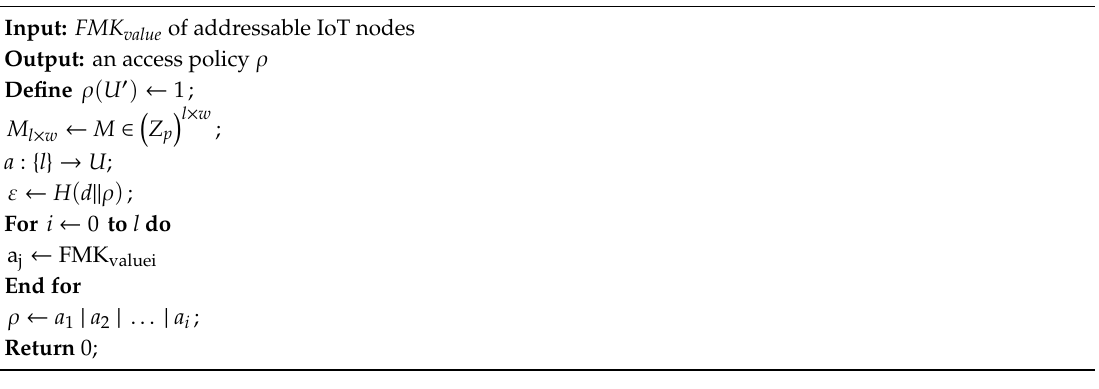
Algorithm 4 Set up An Access Policy